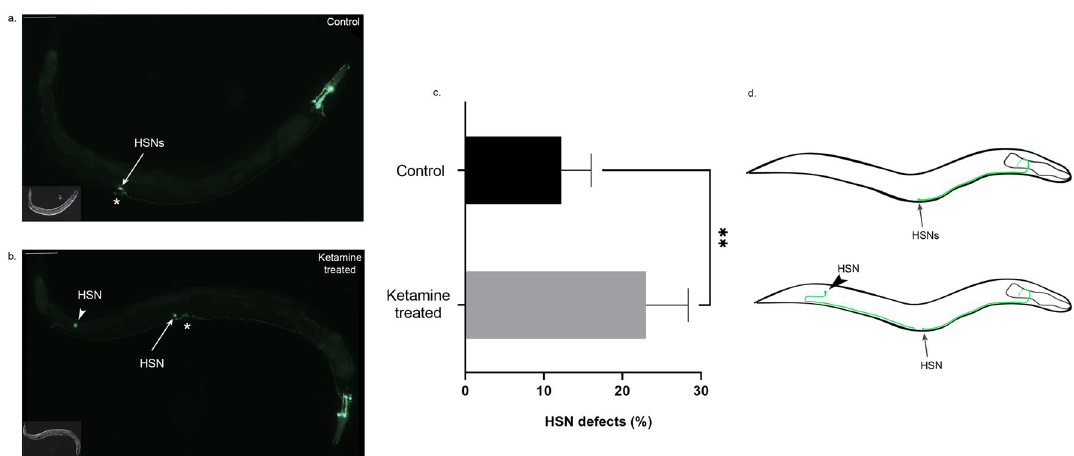
Figure 5. Ketamine-treated animals display HSN migration defect at adult stage ( a ) In control animal expressing tph-1 ::GFP at adult stage, HSN cell bodies marked with an arrow migrate to the midbody being positioned posterior to the vulva. ( b ) In ketamine-treated animals, one of the HSNs fail to migrate to its correct body position. HSN with a migration defect is shown with an arrowhead. ( c ) Migration defects of control (n = 252) and ketamine-treated animals (n = 258) were compared. Four biological replicates were used. (Student’s t -test, paired, mean ± sem, p = 0.0055; ** p < 0.01). ( d ) Illustration of HSN migration at adult stage. HSN cell bodies are located posteriorly near the vulva in a wild-type animal. In ketamine-treated animals, one of the HSN cell body fails to migrate to its correct position. Asterisk indicates vulva. Scale bar 75 μm. Anterior is to the (Supplementary Table 1b). Top 5 GO category included iron ion binding (GO:0005506), tetrapyrrole binding (GO:0046906), collagen trimer (GO:0005581) and steroid hydroxylase activity (GO:0008395). Tetrapyrrole binding (GO:0046906), iron ion binding (GO:0005506) and steroid hydroxylase activity (GO:0008395) catego- ries had similar set of genes all of which are stress response genes corresponding to cytochrome P450 family. As expected, CYP genes are activated for detoxification of the animal. Cuticle development (GO:0042335) and molting cycle (GO:0042303) were also among the GO list ranked as 7th and 9th, respectively. Cuticular collagens significantly upregulated in ketamine-treated wild-type animals are listed in Table 1, along with two additional